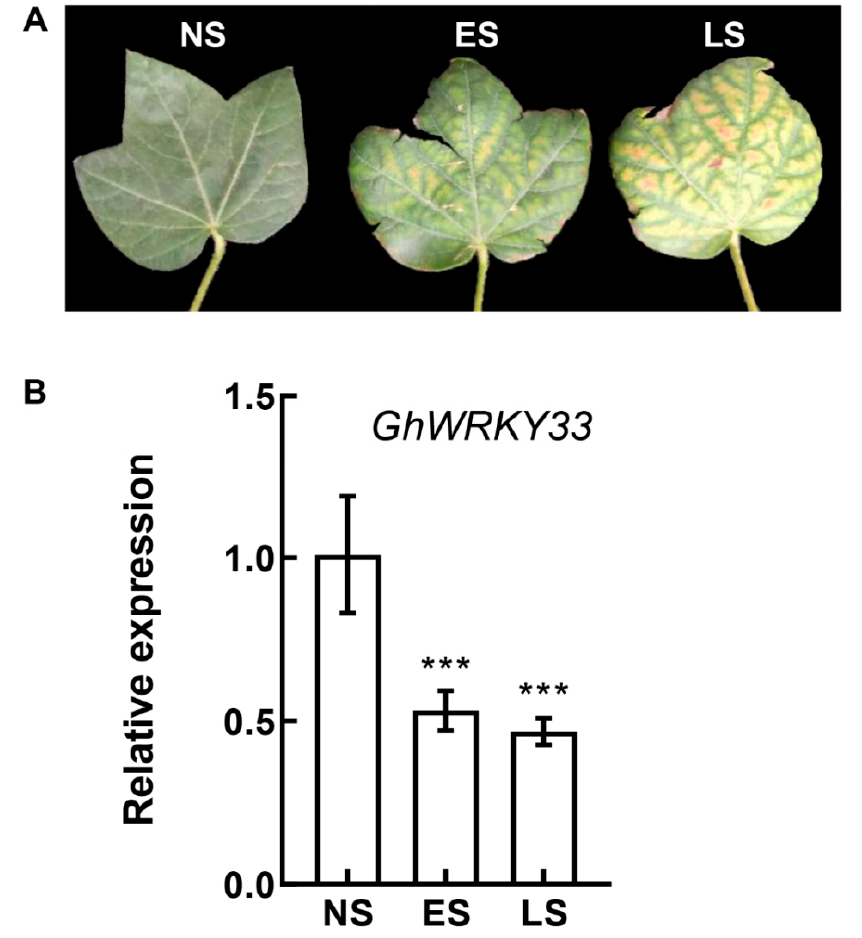
Figure 2. Expression of GhWRKY33 in senescing leaves. ( A ) Different stages of leaf senescence. NS, a fully expanded, non-senescent leaf; ES, an early senescent leaf, with <50% leaf area yellowing; LS, a late senescent leaf, with >50% leaf area yellowing. ( B ) RT-qPCR analysis of GhWRKY33 transcript levels in wild-type leaves at different developmental stages. Transcript levels of GhWRKY33 in NS leaves were arbitrarily set to 1. Data from three biological replicates were analyzed by ANOVA, and asterisks indicate significant differences compared with NS leaves (*** p <